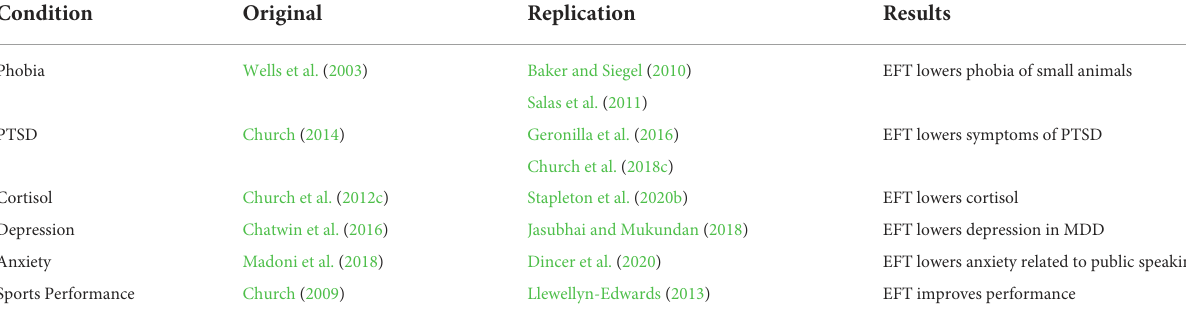
TABLE 17 Original and replication